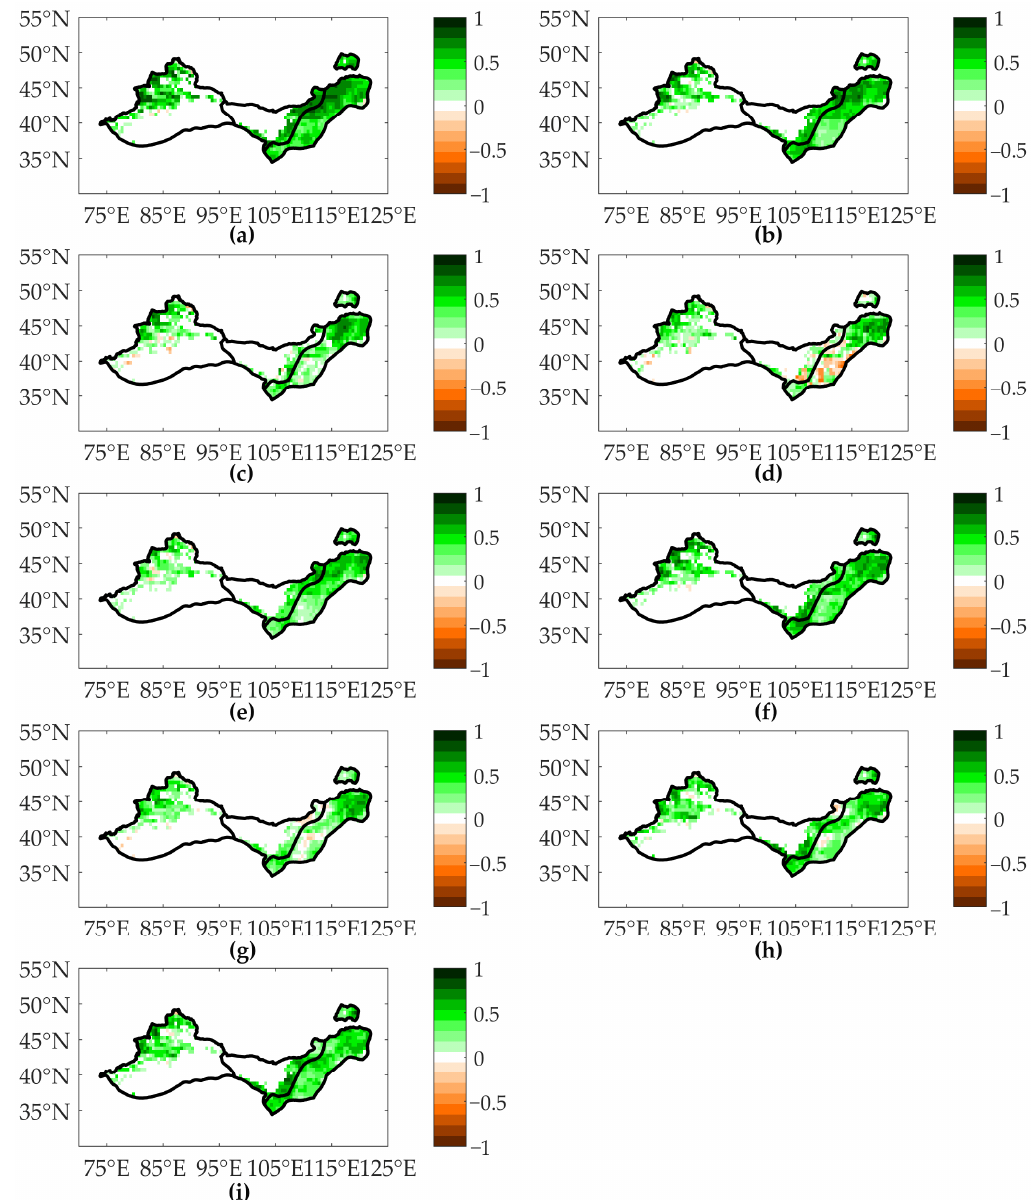
Figure 6. The correlation between M-S NDVI and nine O-S dryness indicators. In the study area, the max NDVI of each grid lower than 0.2 was not be used. ( a ) CMA_P; ( b ) CRU_P; ( c ) PDSI; ( d ) sc_PDSI; (e) SPEI-01; ( f ) SPEI-06; ( g ) SPEI-12; ( h ) Root_sm; ( i ) Surf_sm.